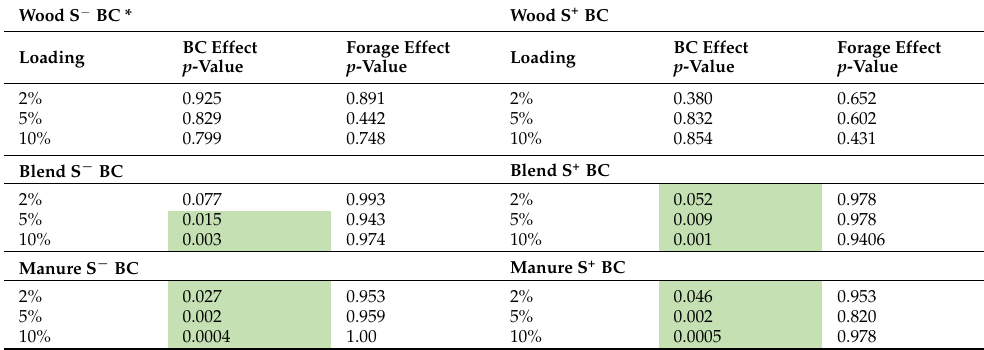
Table 10. Impact of BC and forage application on phosphorus in soil for L. multiflorum . Green highlighted cells are significant values.